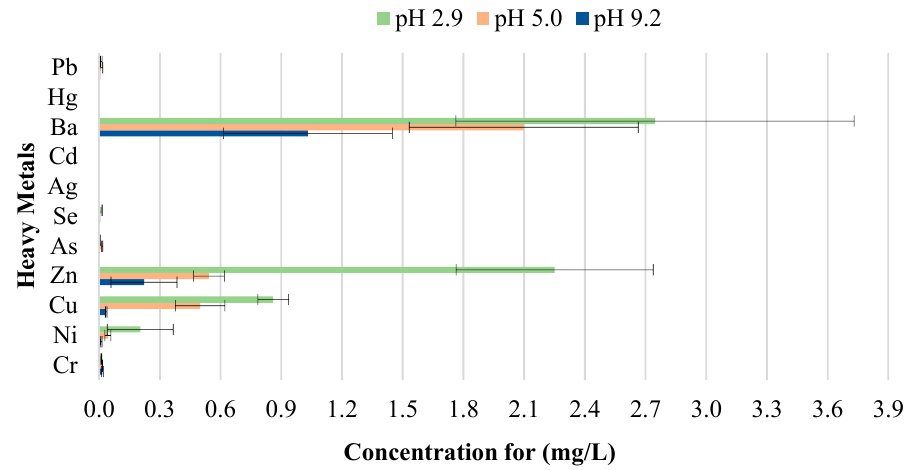
Figure 15. Leachate concentrations for crushed bricks with 2% CB content.